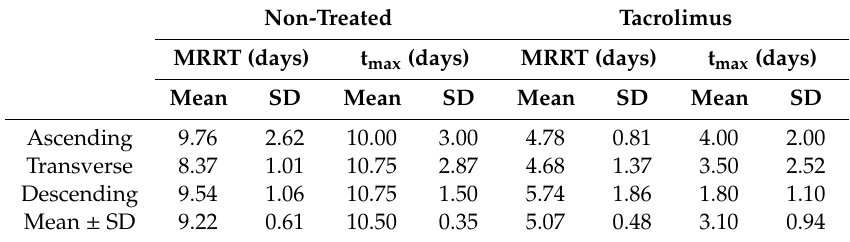
Table 1. Comparison of the mean rat recovering time (MRRT) and t max values of SUV max vs. time with and without tacrolimus treatment.